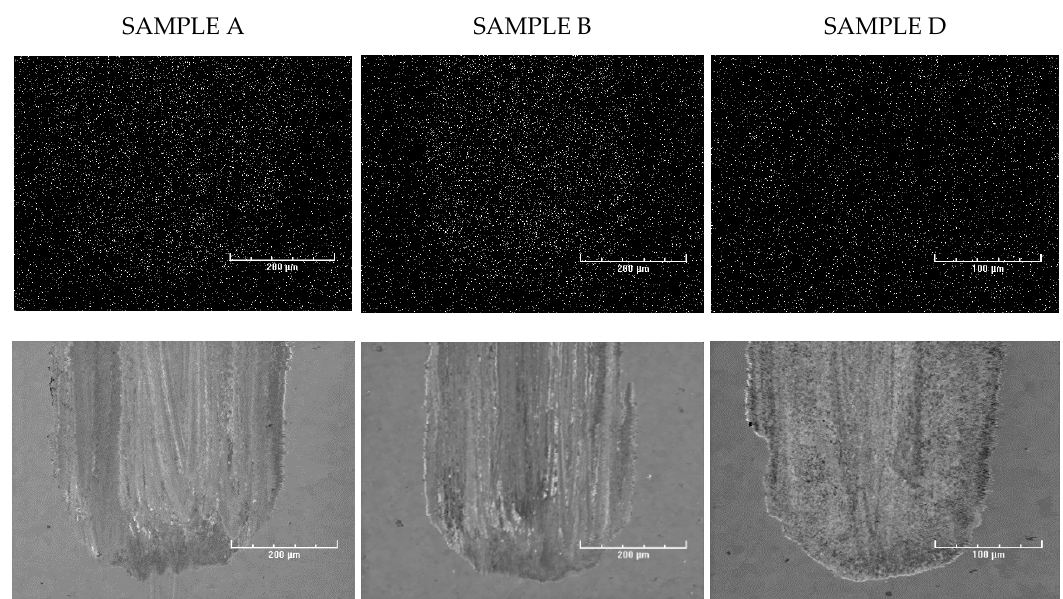
Figure 9. EDS carbon signal in the friction tracks of sample plates A, B, and D (top three images), and the corresponding SEM images below.